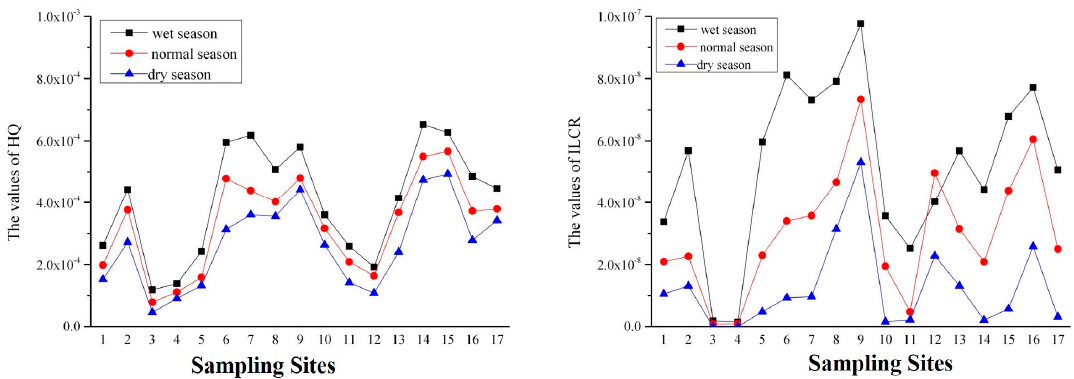
Figure 7. Total hazard quotient (HQ) and incremental lifetime cancer risk (ILCR) of five phenolic compounds in 17 sampling sites.